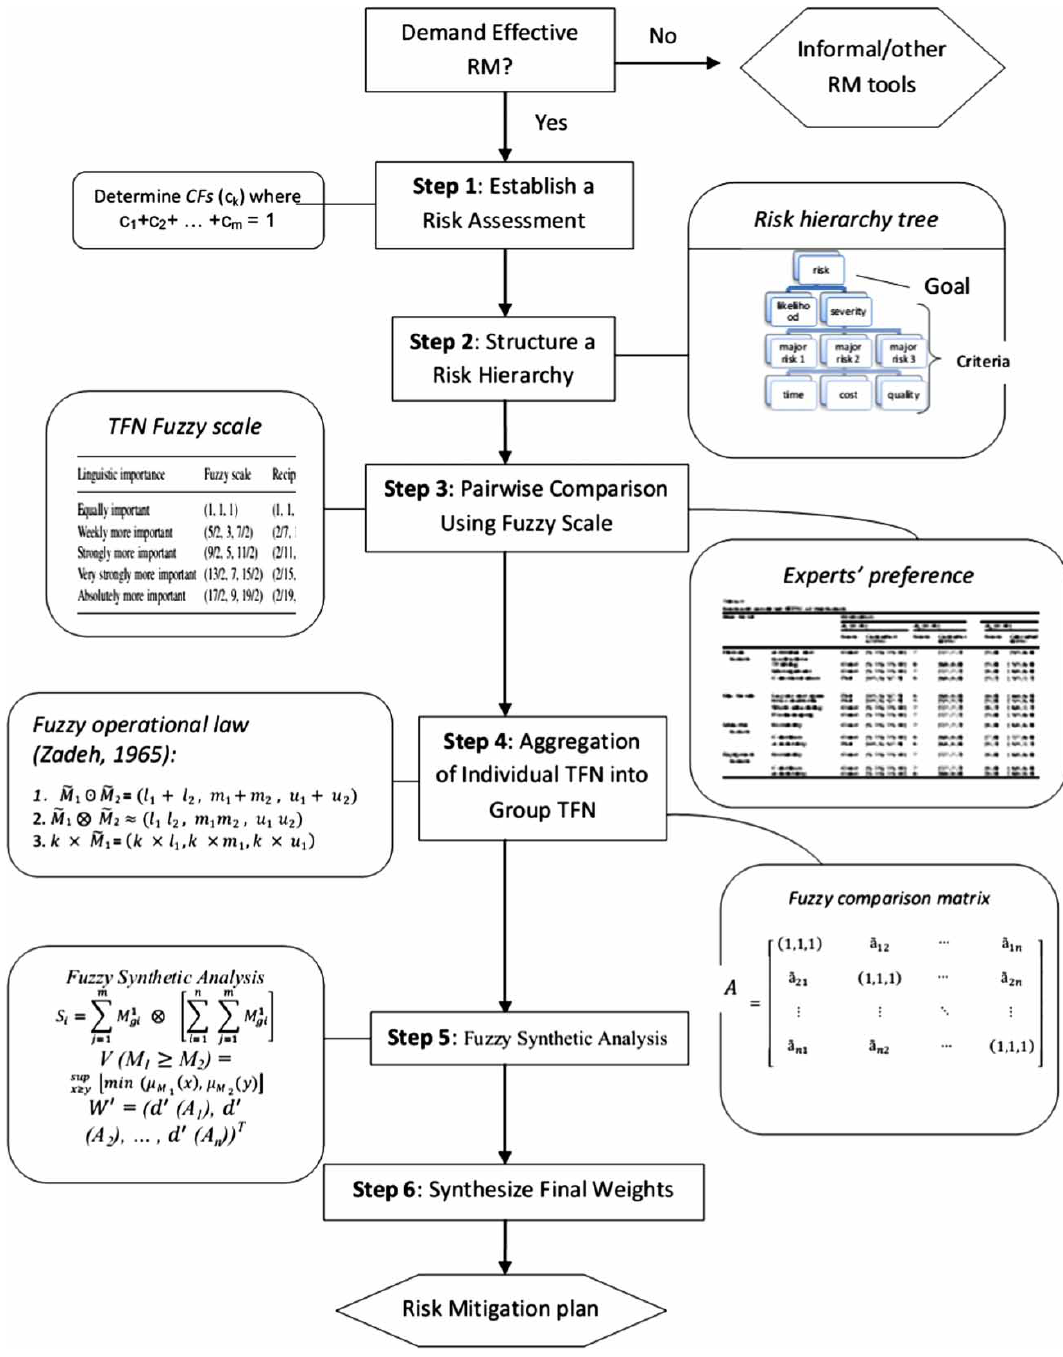
Fig. 3. The developed Fuzzy Synthetic Model